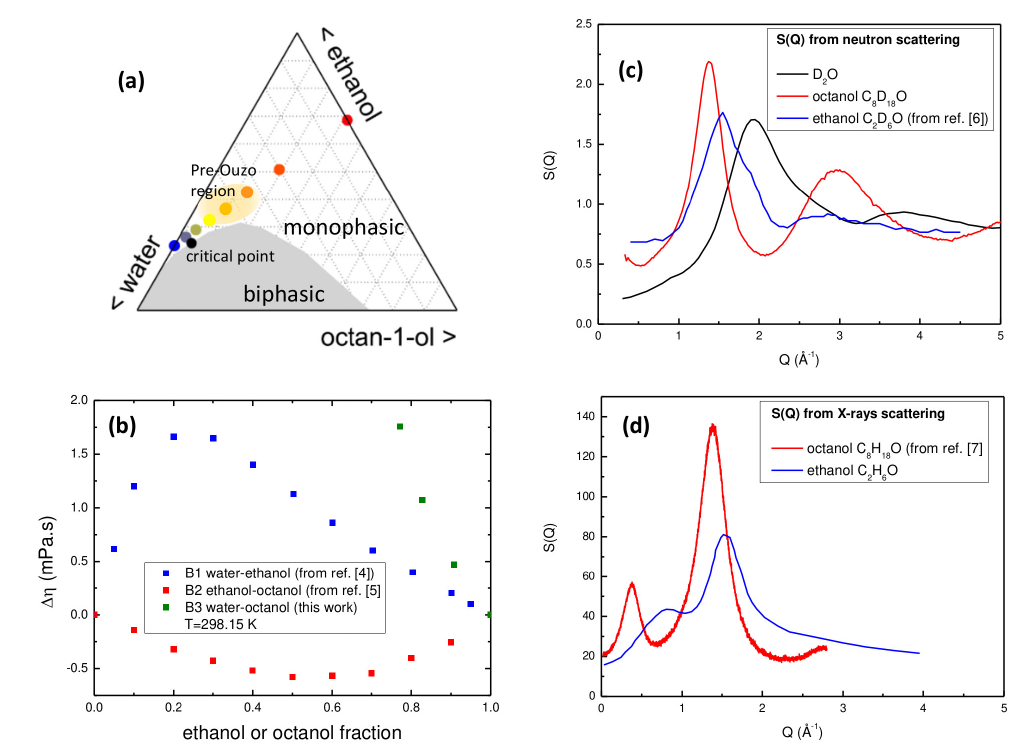
Figure 1. (a) phase diagram of the ternary mixture water-ethanol-octanol, expressed in mole fraction. The dots are distributed over the line of interest for the understanding of the ternary mixture. (b): excess viscosity for the three binary mixtures in ethanol or octanol mole fraction in their miscibility range. Data for the water-ethanol and ethanol-octanol are taken from references [4] and [5] respectively.(c) and (d) : structure factor of the pure compounds measured by neutron (our work, measurements on 7C2 at LLB, France and ref [6]) and X-ray di ff raction (our work and ref. [7]